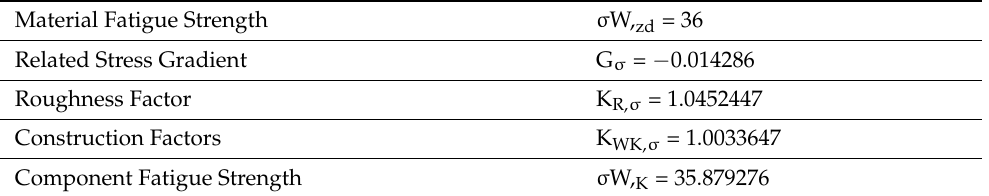
Table 4. Intermediate results of calculations (composition No.